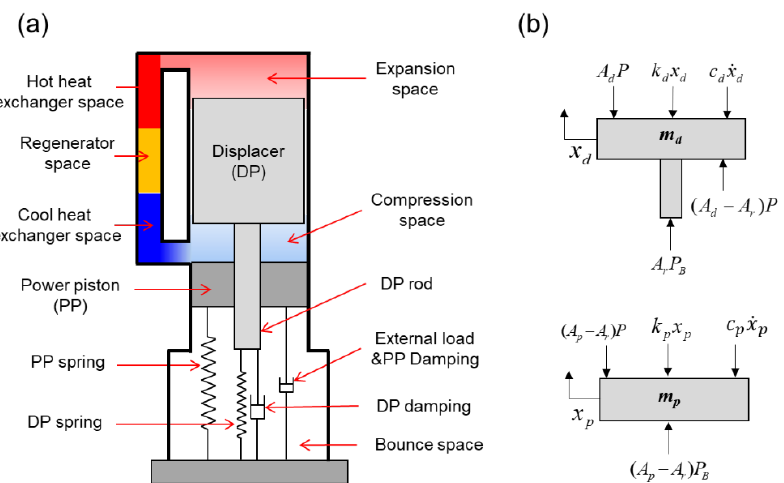
Figure 1. Conceptual diagram of a beta-type free-piston Stirling engine (FPSE) with an external load: ( a ) schematic layout of the engine and ( b ) a free-body diagram of the pistons.